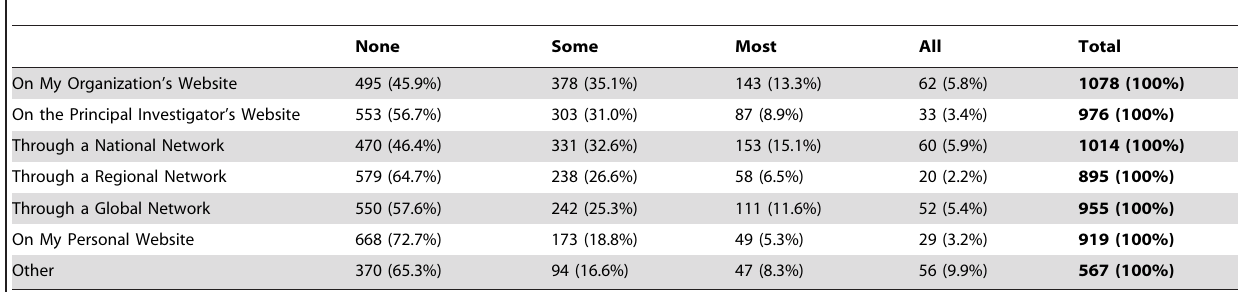
Table 10. Data sharing